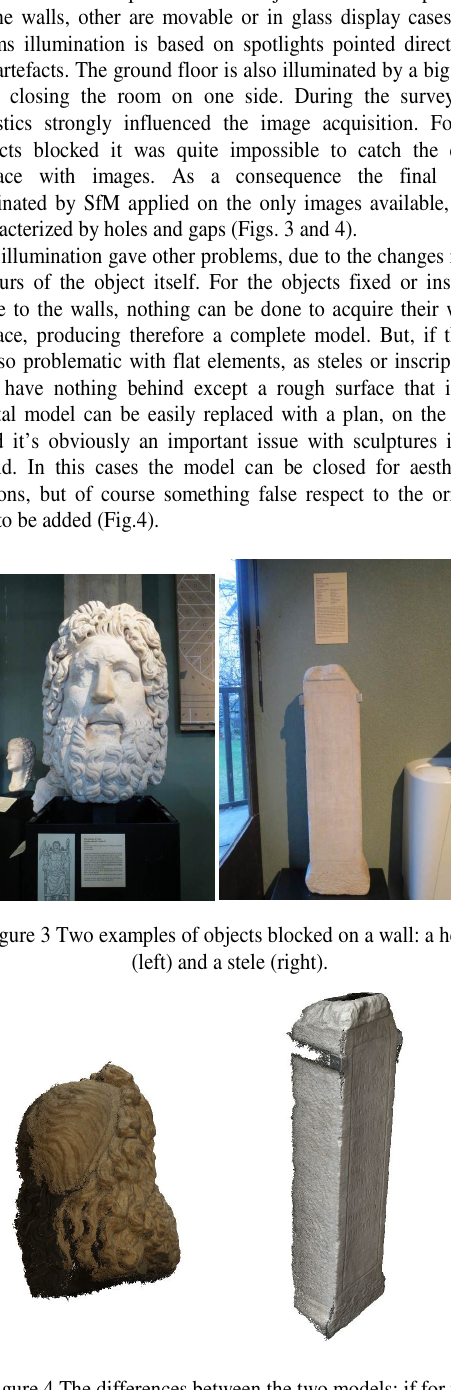
Figure 4 The differences between the two models: if for the stele the gap is not problematic because the rear part is flat and empty, for the head it’s necessary to complete the model by hand, without real